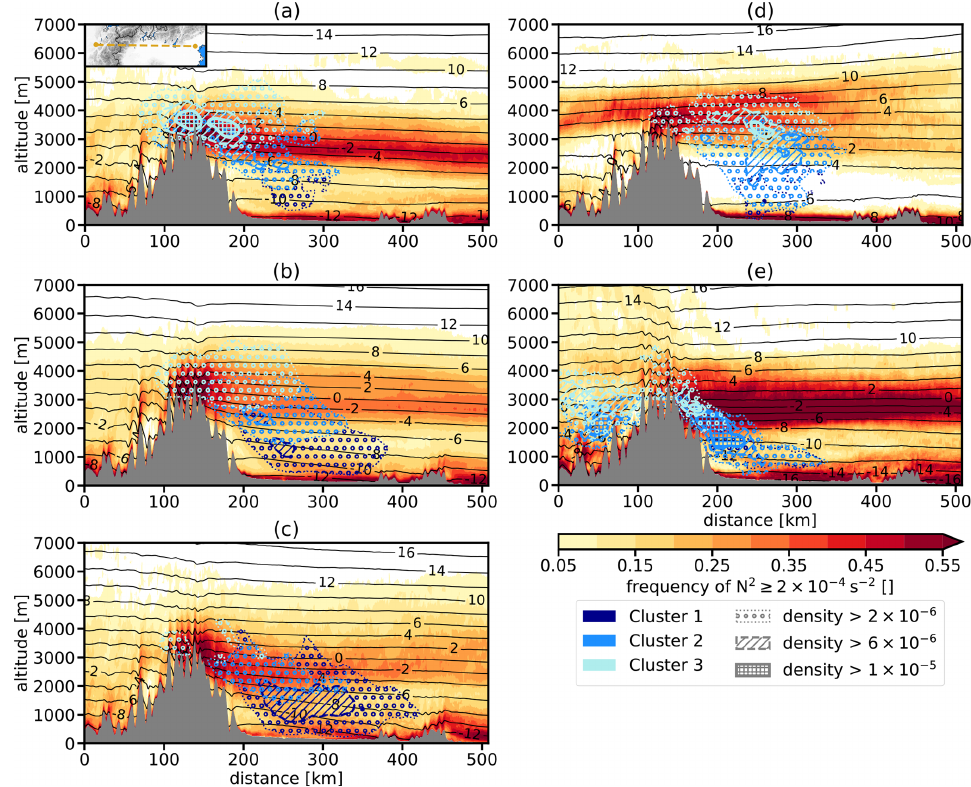
Figure 11. Frequency of N 2 being equal to or exceeding 2 × 10 − 4 s − 2 in east–west-oriented vertical cross-section composites. Trajectory intersections for the three clusters (different shades of blue) are binned along the cross section and displayed as hatched contours (density > 2 × 10 − 6 with circles, > 6 × 10 − 6 with lines, > 1 × 10 − 5 with squares). Normalized potential temperature is displayed (black contours) as in Fig. 4. (a) Dry foehn; (b) moist foehn; (c) dimmer foehn; (d) shallow foehn; (e) gegenstrom